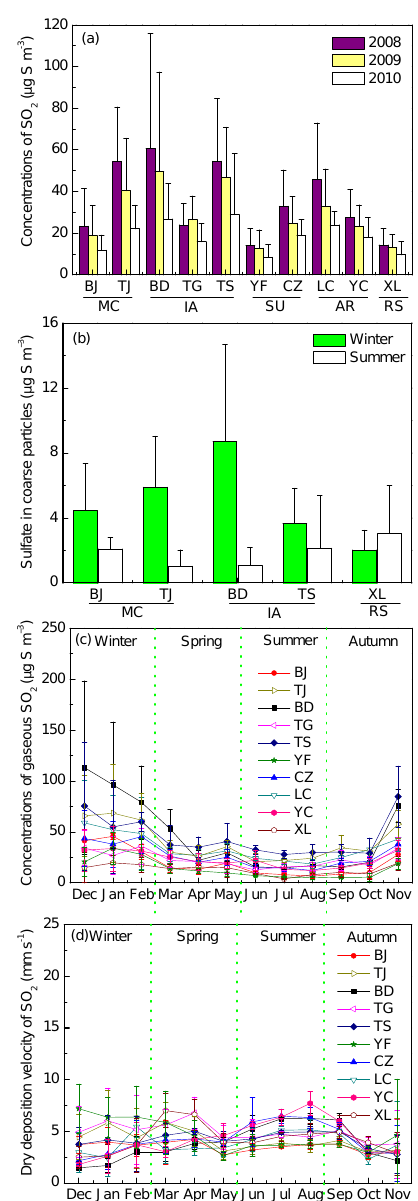
Fig. 2. Spatial variations of the concentrations and dry deposition velocities of SO 2 and sulfate in Northern China. The concentration data of SO 2 are monthly means during the 3-yr observations, with the error bars denoting standard deviation (a) . The concentrations of sulfate in coarse particles during the winter (from December 2009 to February 2010) and summer (from June to August 2010) at the five sites are derived from (Sun, 2011), with the error bars denot- ing standard deviation (b) . More sampling and analysis information was available in our previous paper (Pan et al., 2012). MC, IA, SU, AR and RS denote urban, industrial, suburban, agricultural and ru- ral sites, respectively. Seasonal variations of the concentrations (c) and dry deposition velocities (d) of SO 2 shown are the monthly mean ± standard deviations of 3-yr observations (from December 2007 to November 2010). The definition of the site codes is found in Sect.